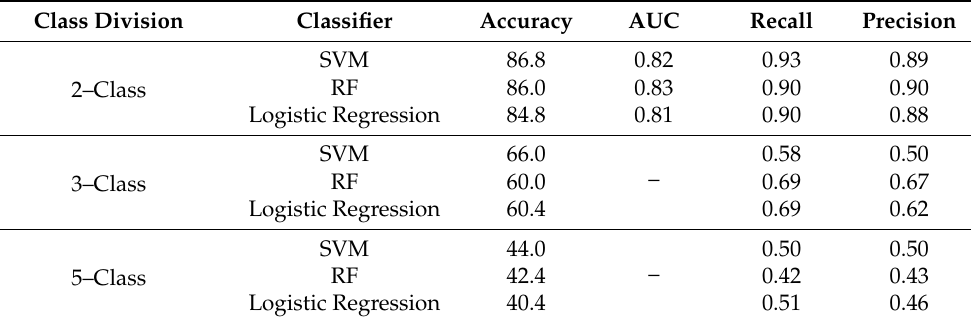
Table 1. Classification performance analysis—LDA feature extractor.